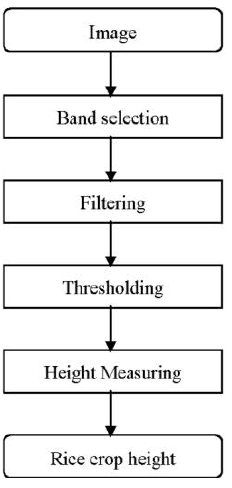
Figure 3. The rice crop height measurement